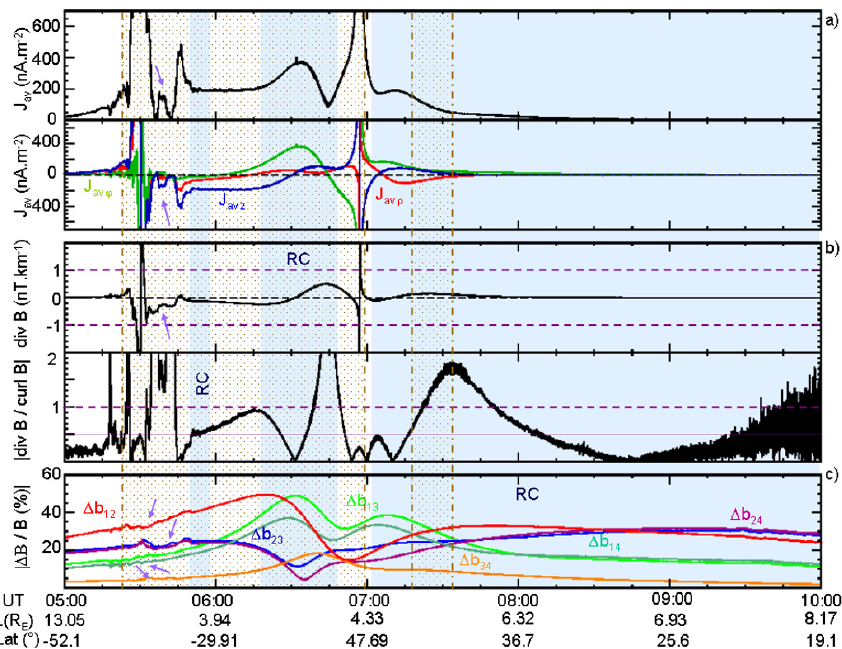
Fig. 6. Estimation of the current density along the Cluster orbit on 15 May 2009 ring current region crossing. Frame (a) : time evolution of | J av | (top panel) and its components in cylindrical coordinates (bottom panel). Frame (b) : div B and | div B (cid:14) curlB | . Frame (c) : 1b ij = B i − B j / B , with i and j the satellite number (panel a ). In each frame, the blue shaded areas indicate the time intervals when the ring current is observed on C1 data. The brown dashed lines are located where | div B |= 1nTkm − 1 . The L-shell and the magnetic latitude of C1 is given in Fig. 6. As the current density is calculated using the four satellites, these values are indicative and only give an average